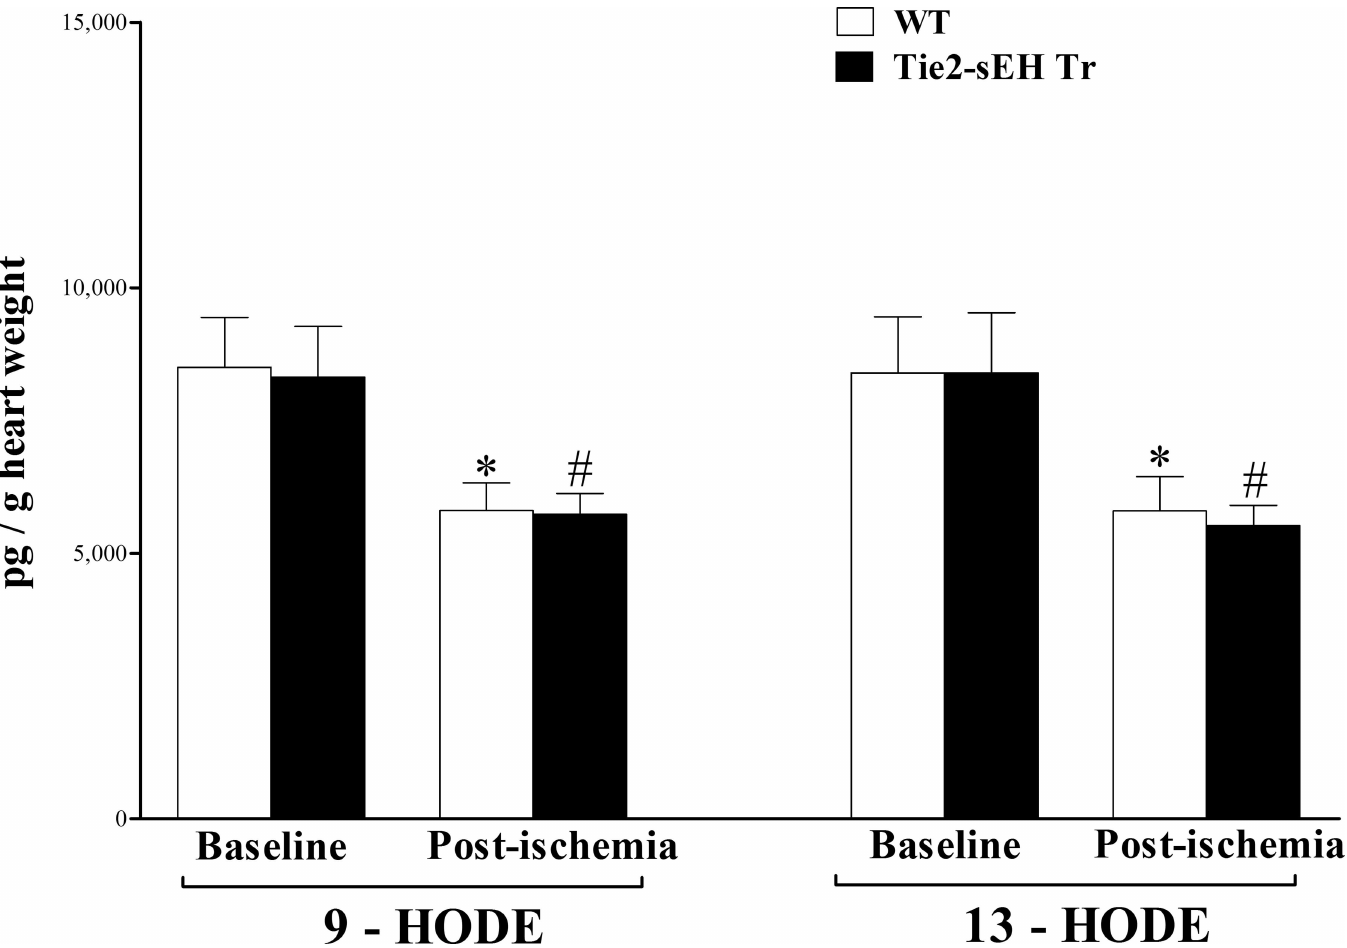
Fig 6. LC–MS/MS analysis of HODEs in WT and Tie2-sEH Tr mouse heart perfusates at baseline and post-ischemia. In both WT and Tie2-sEH Tr, 9- and 13-HODEs decreased in responseto ischemia( P < 0.05). However, they were not significantly different betweenthe two groups at baselineor post- ischemia( P > 0.05). * P < 0.05 versus baselineWT. # P < 0.05 versus WT post-ischemia. n = 12 WT and 14 Tie2-sEH